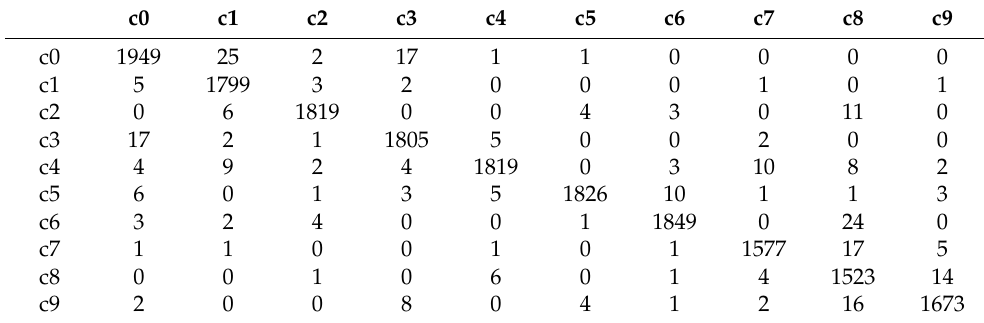
Table 7. Confusion matrix for the Kaggle data